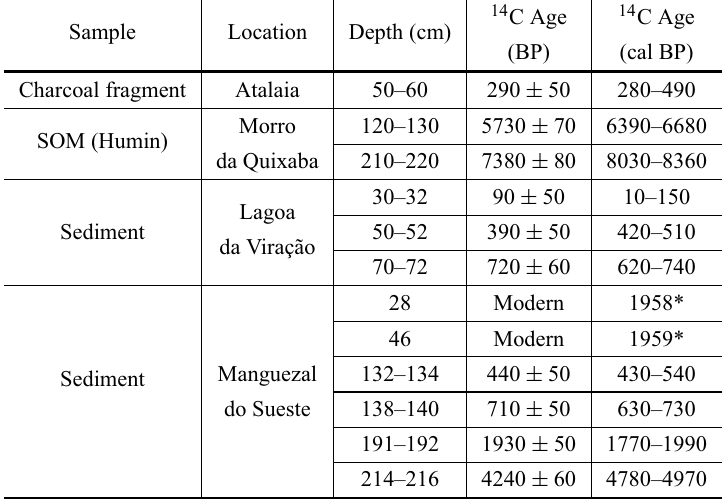
TABLE III 14 C dating of charcoal fragment, soil organic matter and sediment samples from Lagoa da Viração e Manguezal do